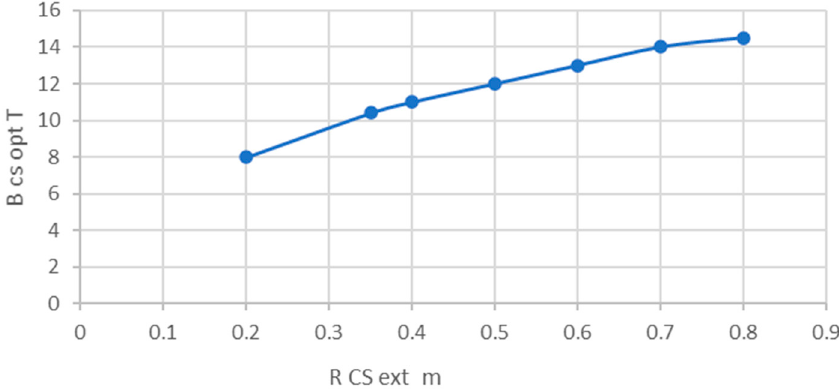
Figure 4. Optimum maximum CS field B cs opt as a function of the external radius of CS, R CS ext , calculated for σ max = 500 MPa and a constant current density in the winding pack J wp = 80 MA/m 2 .